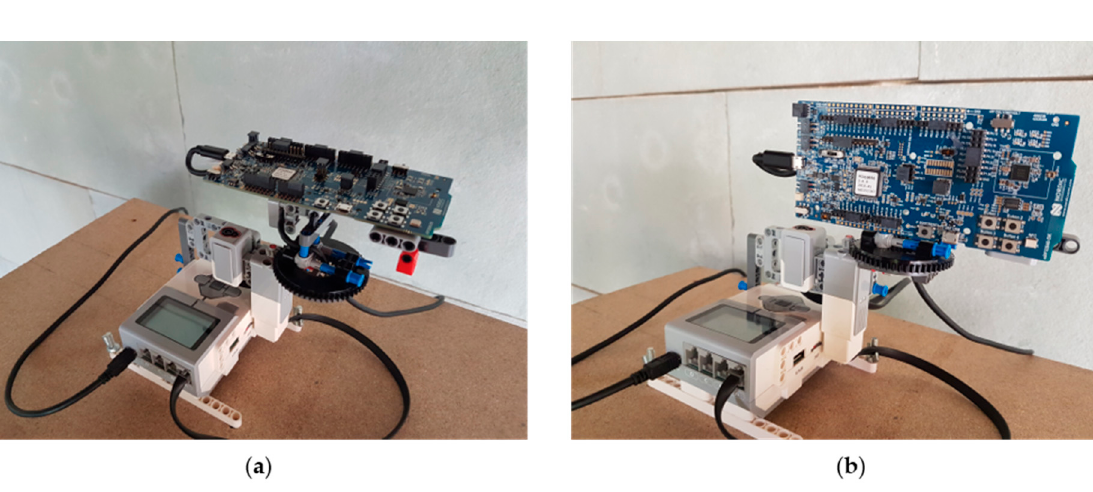
Table 1. Transmitter power ( Tx ) codes in both brands of beacons.